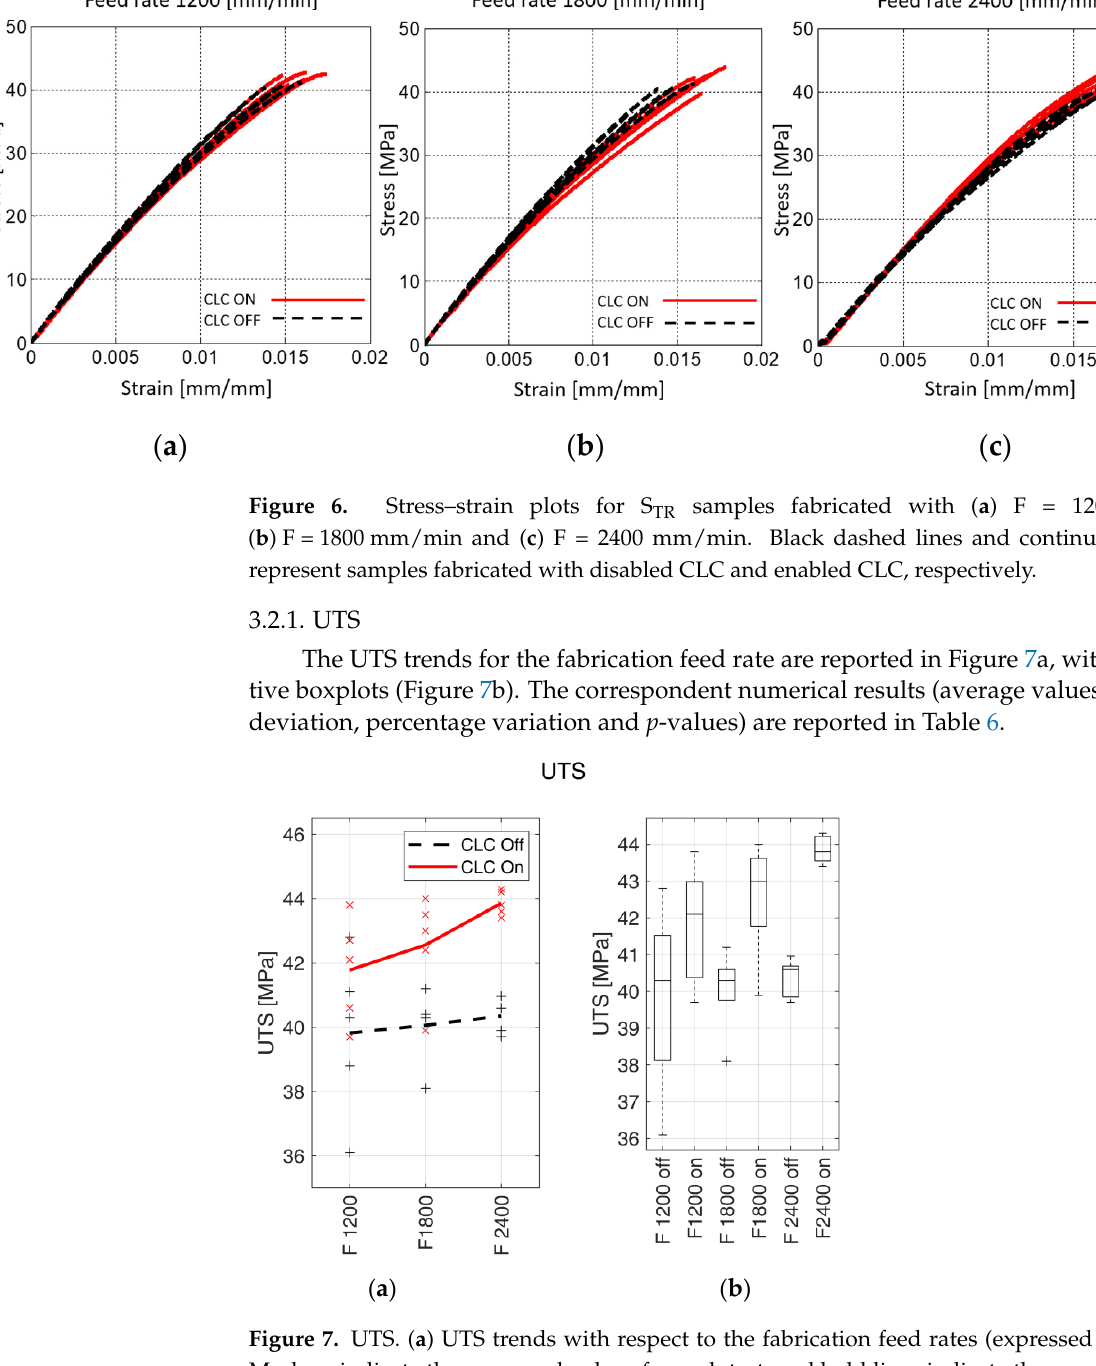
Table 7. Elongation at break. 𝛆 𝐦𝐚𝐱 (%)